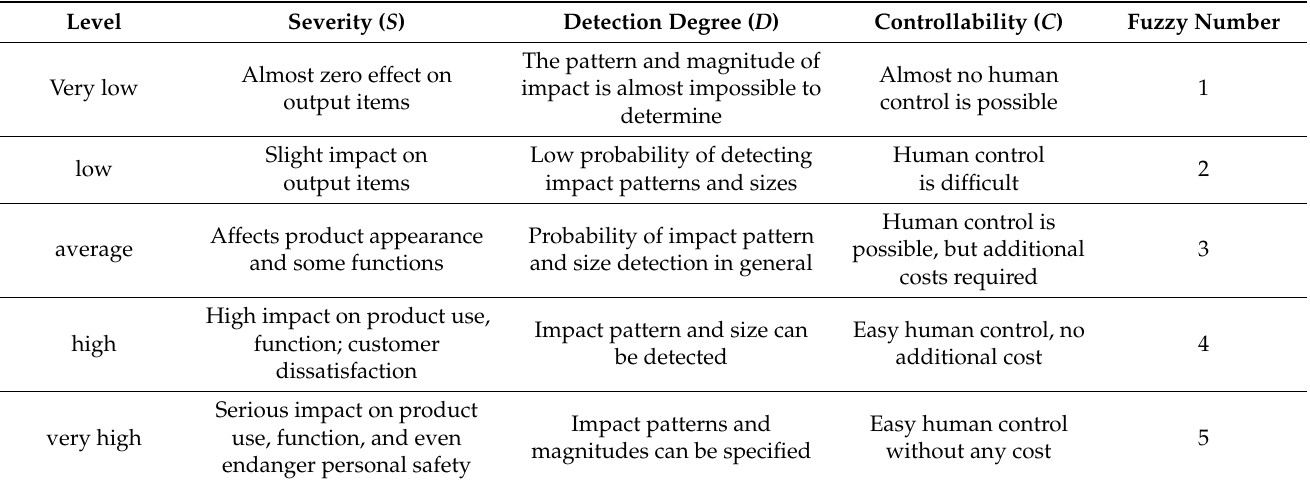
Table 1. The language